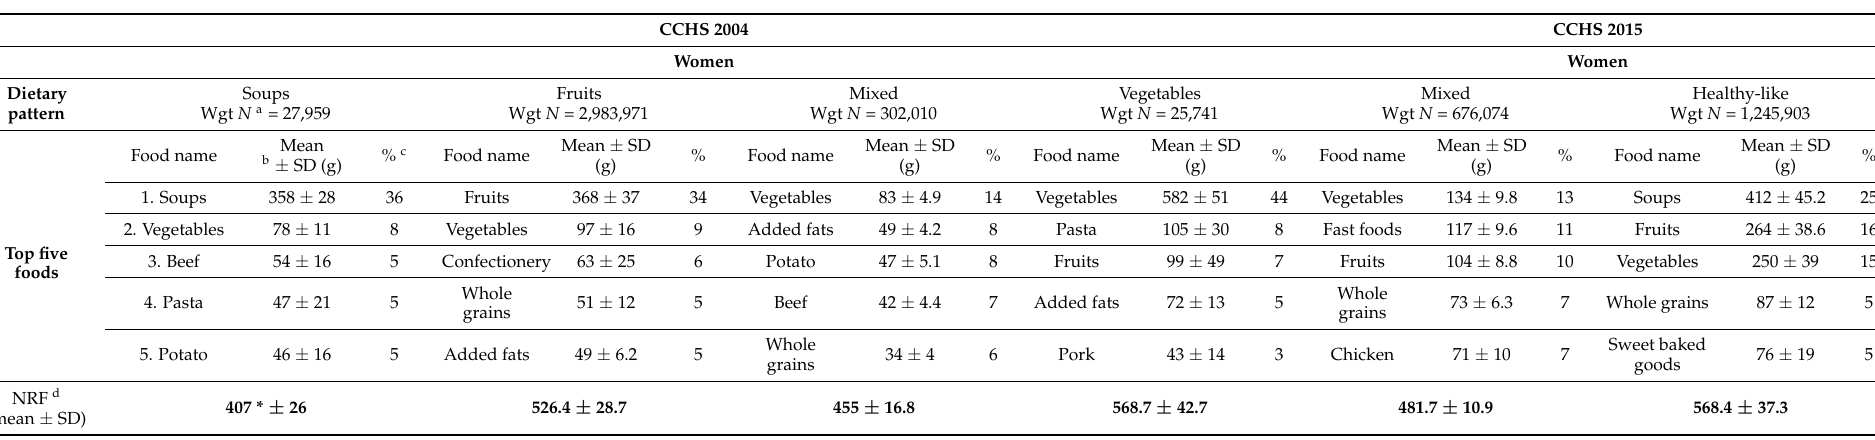
Table 3. Dietary patterns of Indigenous women in 2004 and